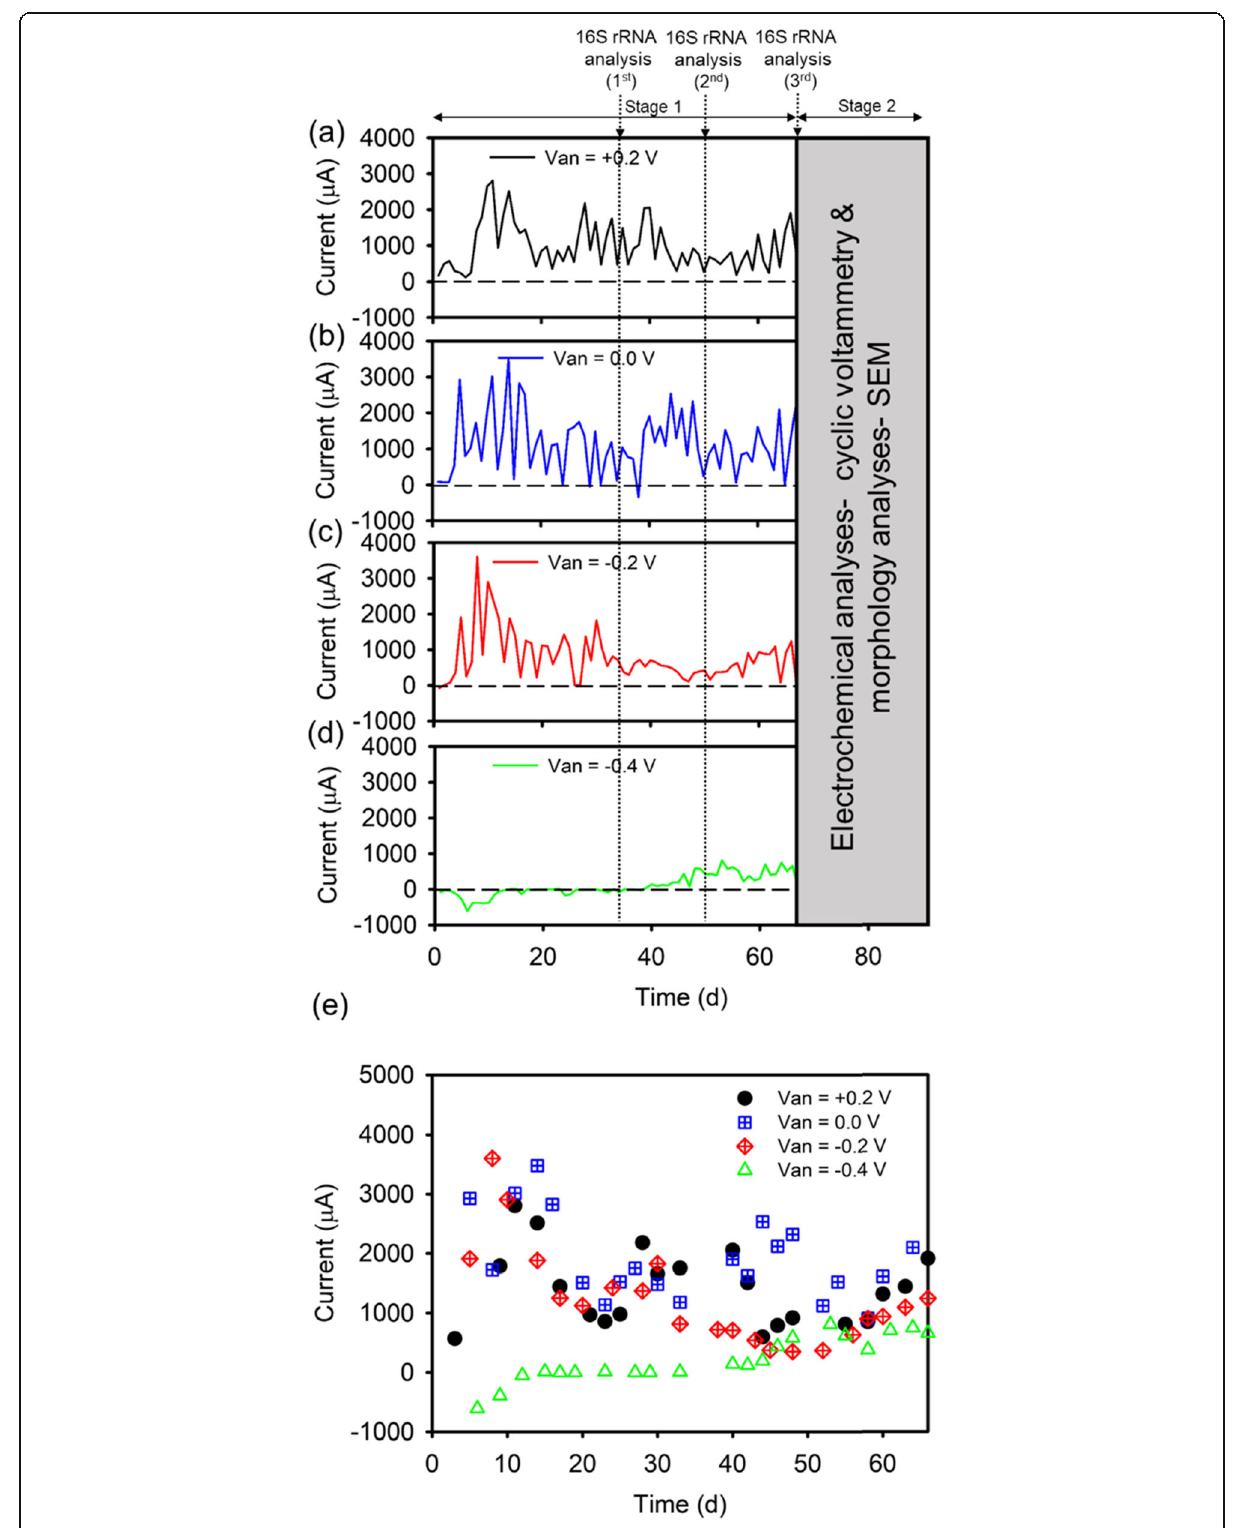
Fig. 1 Current production at four poised potentials from substage 1 to 3 and electrochemical and morphology analyses after substage 3. ( a ) anode cultivated at poised potential of +0.2 V; ( b ) anode cultivated at poised potential of 0 V; ( c ) anode cultivated at poised potential of − 0.2 V; ( d ) anode cultivated at poised potential of − 0.4 V; ( e ) peak current production at four poised potentials from substage 1 to